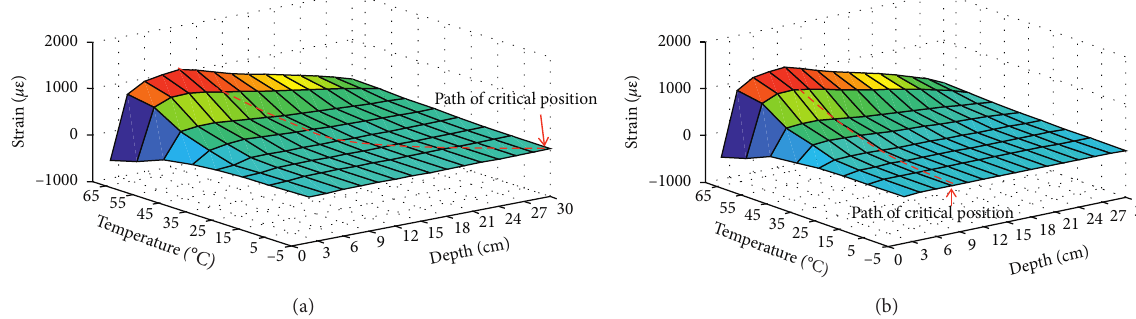
Figure 14: The distributions of strains within asphalt layers of (a) flexible pavement and (b) semirigid pavement under vehicular